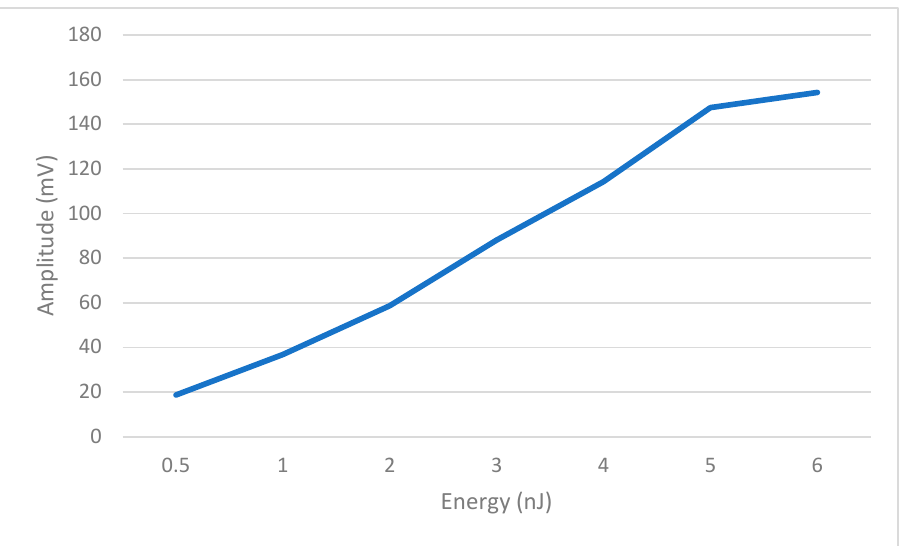
Figure 8. Change of output amplitude with different laser energy levels.